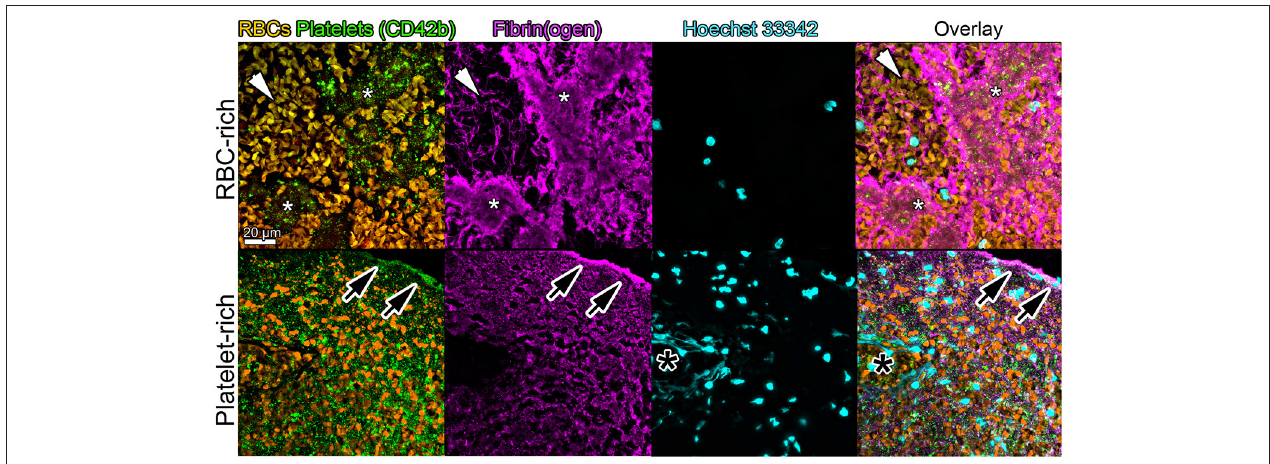
FIGURE 5 | Immunohistological aspects of retrieved thrombi causing LVO in the simulating system. Representative images showing platelets (CD42b, green), red blood cells (RBCs, yellow), fibrin (ogen) (magenta), and DNA (Hoechst 33,342, blue) staining in the core of a retrieved RBC-rich (upper panels) or platelet-rich (lower panels) thrombus. Note the stark contrast in fibrin structure between the platelet-rich (*, white asterisks) and RBC-rich (white arrowheads) areas in the inner core of the RBC-rich thrombus. Also worth noting is the accumulation of fibrin and platelets at the thrombus periphery as shown by the black arrowheads in the platelet-rich thrombus images. The black asterisks indicate the presence of uncondensed DNA, suggestive of neutrophil extracellular